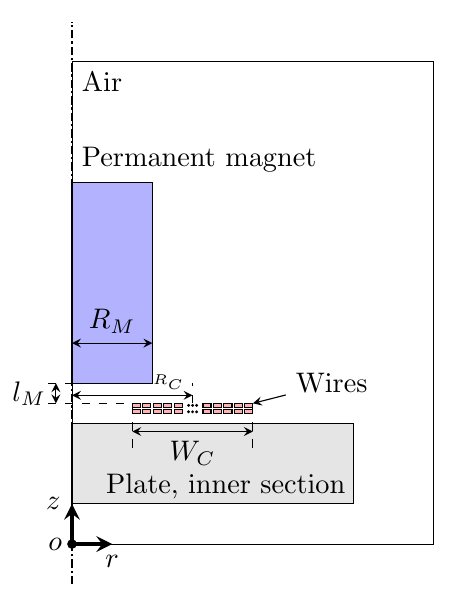
Figure 5. The geometry of the electromagnetic submodels. This geometry is used for magnetostatic analysis and eddy-current anal-